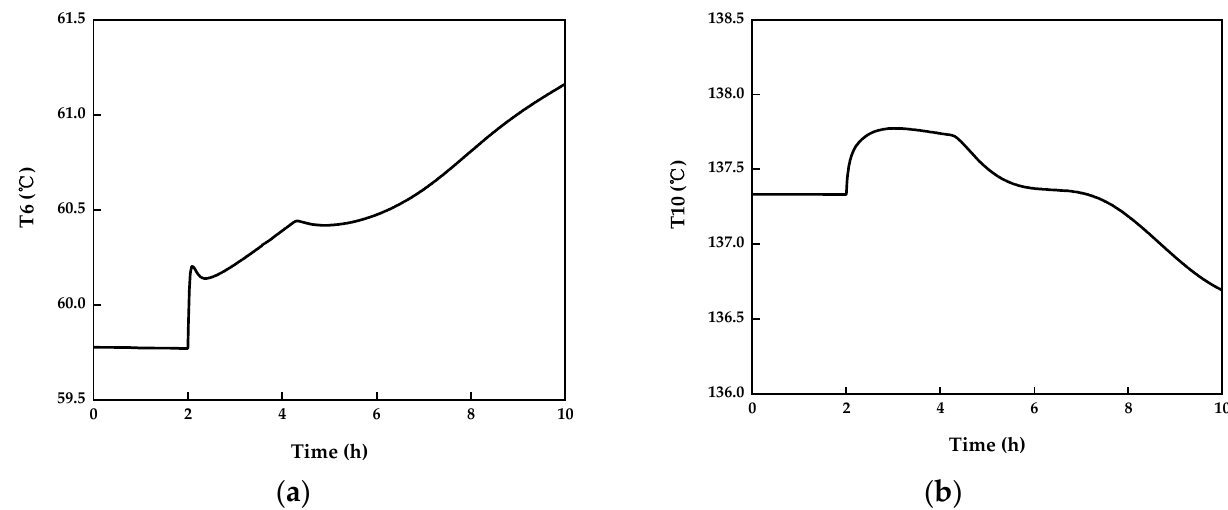
Figure 10. Effect of feed temperature T5 disturbance at 2 h on system: ( a ) the column top temperature T6; ( b ) the column bottom temperature T10.